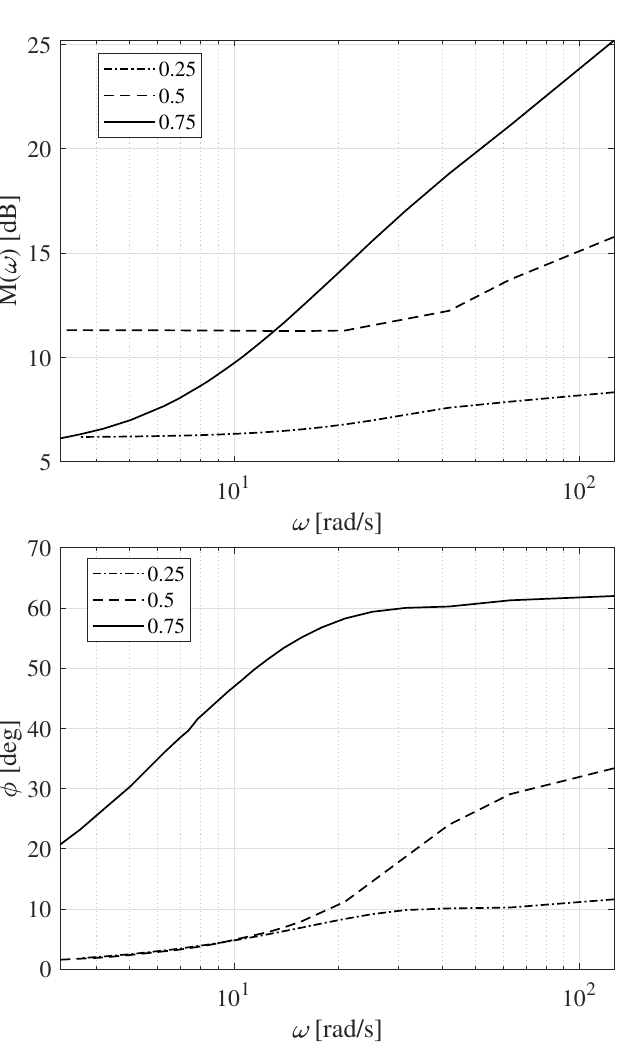
Figure 2. The Bode diagrams of the magnitude and phase of FOPID using FOBD.